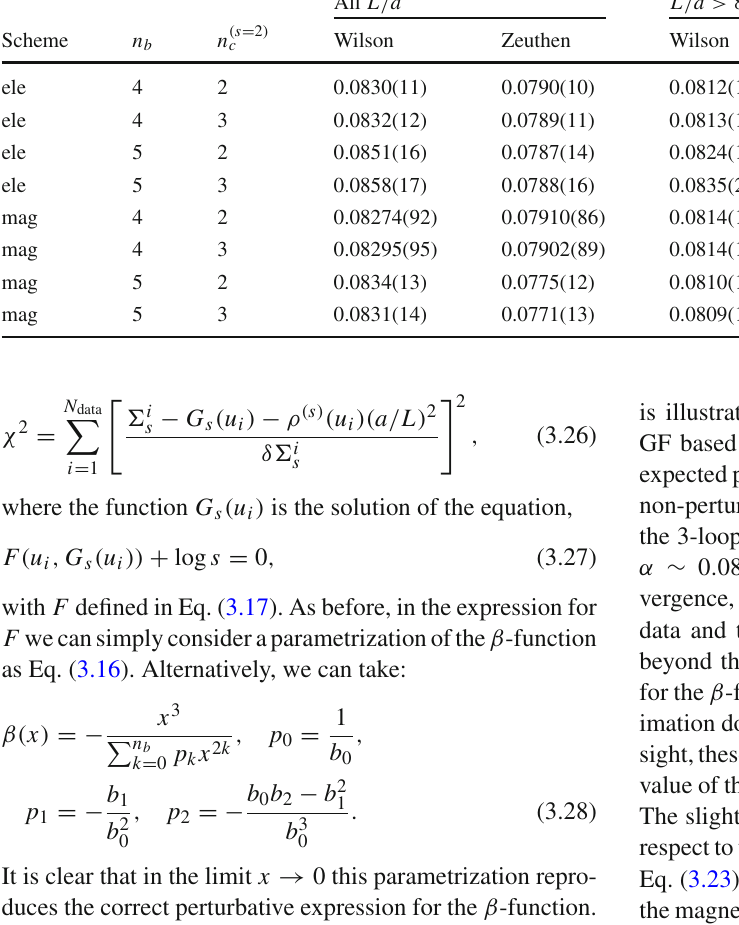
/μ Table 3 Results for (cid:3) ent parametrizations for the β -function and the cutoff effects in our ref from different analysis. We use our MS data for the step-scaling function (cf. Sect. 3.3), to determine the β - data (cf. Eqs. (3.16) and (3.20)), as well as different cuts in the lattice function both in the electric and magnetic schemes. We choose differ- resolution All L / a Wilson Zeuthen Wilson Zeuthen Wilson